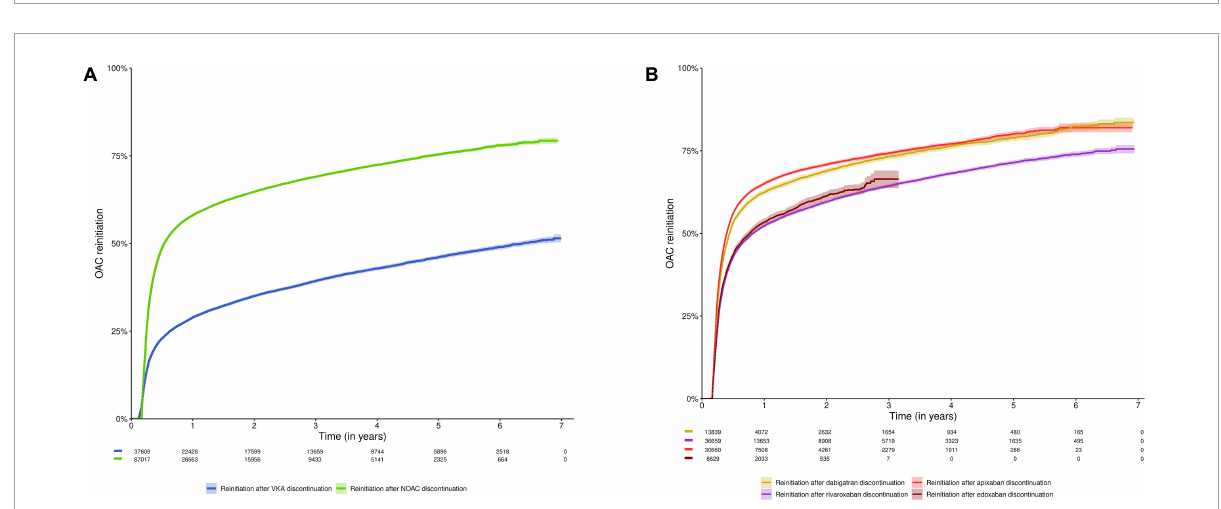
FIGURE3 Cumulative incidence curve of reinitiation of an oral anticoagulant after discontinuation of (A) NOACs and VKAs; and (B) NOAC types (dabigatran, rivaroxaban, apixaban, and edoxaban). Data shown as cumulative incidence with 95% confidence interval and risk table (number of patients at risk). Subjects were included at the date of discontinuation ( n = 125,873). Subjects were censored in case of death, emigration or end of the study period. The initial lag period in the cumulative incidence curves (60 days for NOACs, 42–60 days for VKAs) is due to the definition of discontinuation (arbitrary supply gap of > 60 days after the calculated last day of supply, with the possibility to extend this gap for VKAs in case of intervening INR testing at least every 42 days). Due to their respective approval in September 2013 and October 2016, and the study period ending on December 31st, 2019, the maximum follow-up duration of apixaban and edoxaban users was limited to 6.3 years and 3.25 years, respectively. NOAC, non-vitamin K antagonist oral anticoagulant; OAC, oral anticoagulant; VKA, vitamin K antagonist.